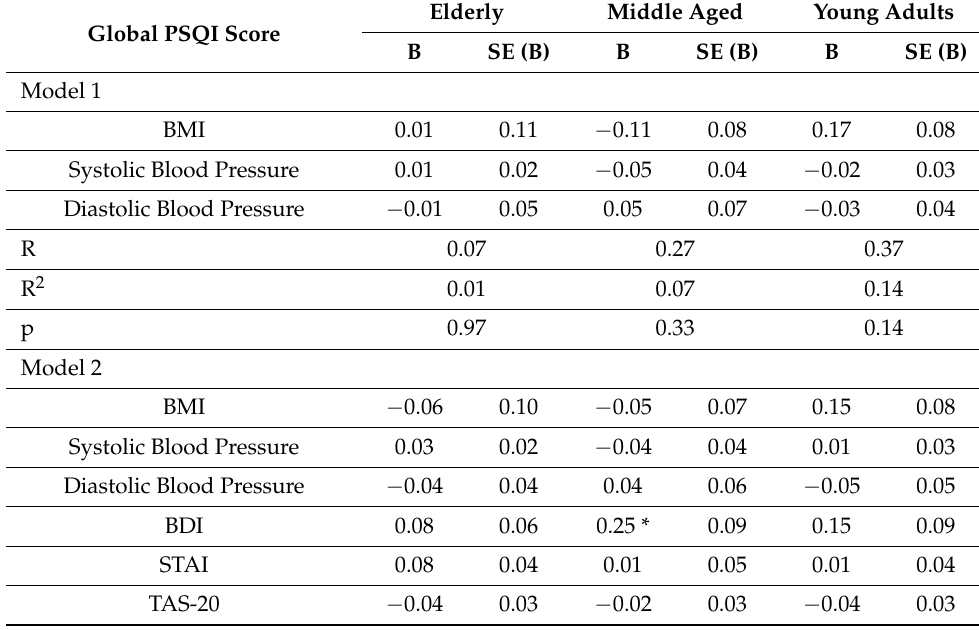
Table 6. Linear regression on Pittsburgh Sleep Quality